Question: Author a descriptive caption for the visualization shown.
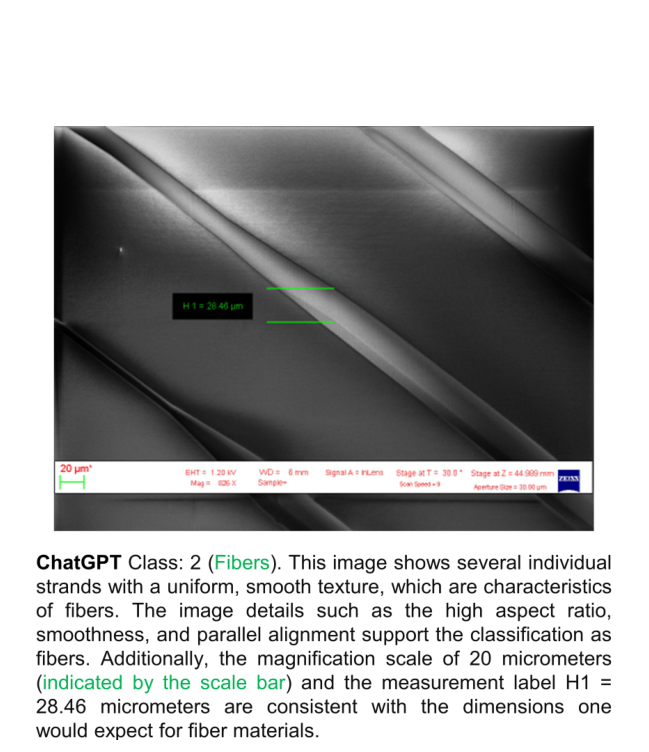
Answer: ChatGPT considered the scale bar while predicting the class of this image as fibers correctly. It is possible that this judgement helped ChatGPT to distinguish it from nanowires. Correct key responses are colored in green.